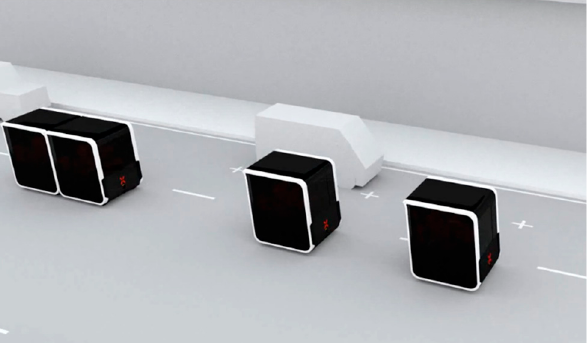
Figure 2. Coupling and disassembly of electric modular vehicles (source: https://www.next-future- mobility.com, accessed on 5 June 2021).